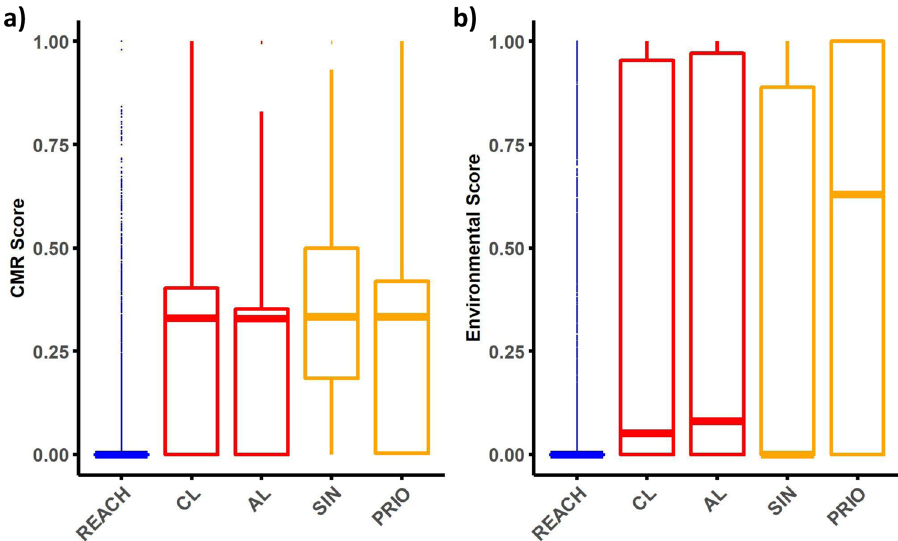
Fig. 1 | Distribution of CMR and Environmental Score across chemical lists. Panels ( a ) and ( b ) present the distribution of the CMR Score, measuring Carcino- genicity (C), Mutagenicity (M), and Reproductive toxicity (R), and the Environ- mentalScore,measuringenvironmentalhazard,acrossthe fi veexaminedchemical lists. Note that some compounds could not be assigned a score as there was no matching entry in the classi fi cation and labeling inventory. Sample size ( a